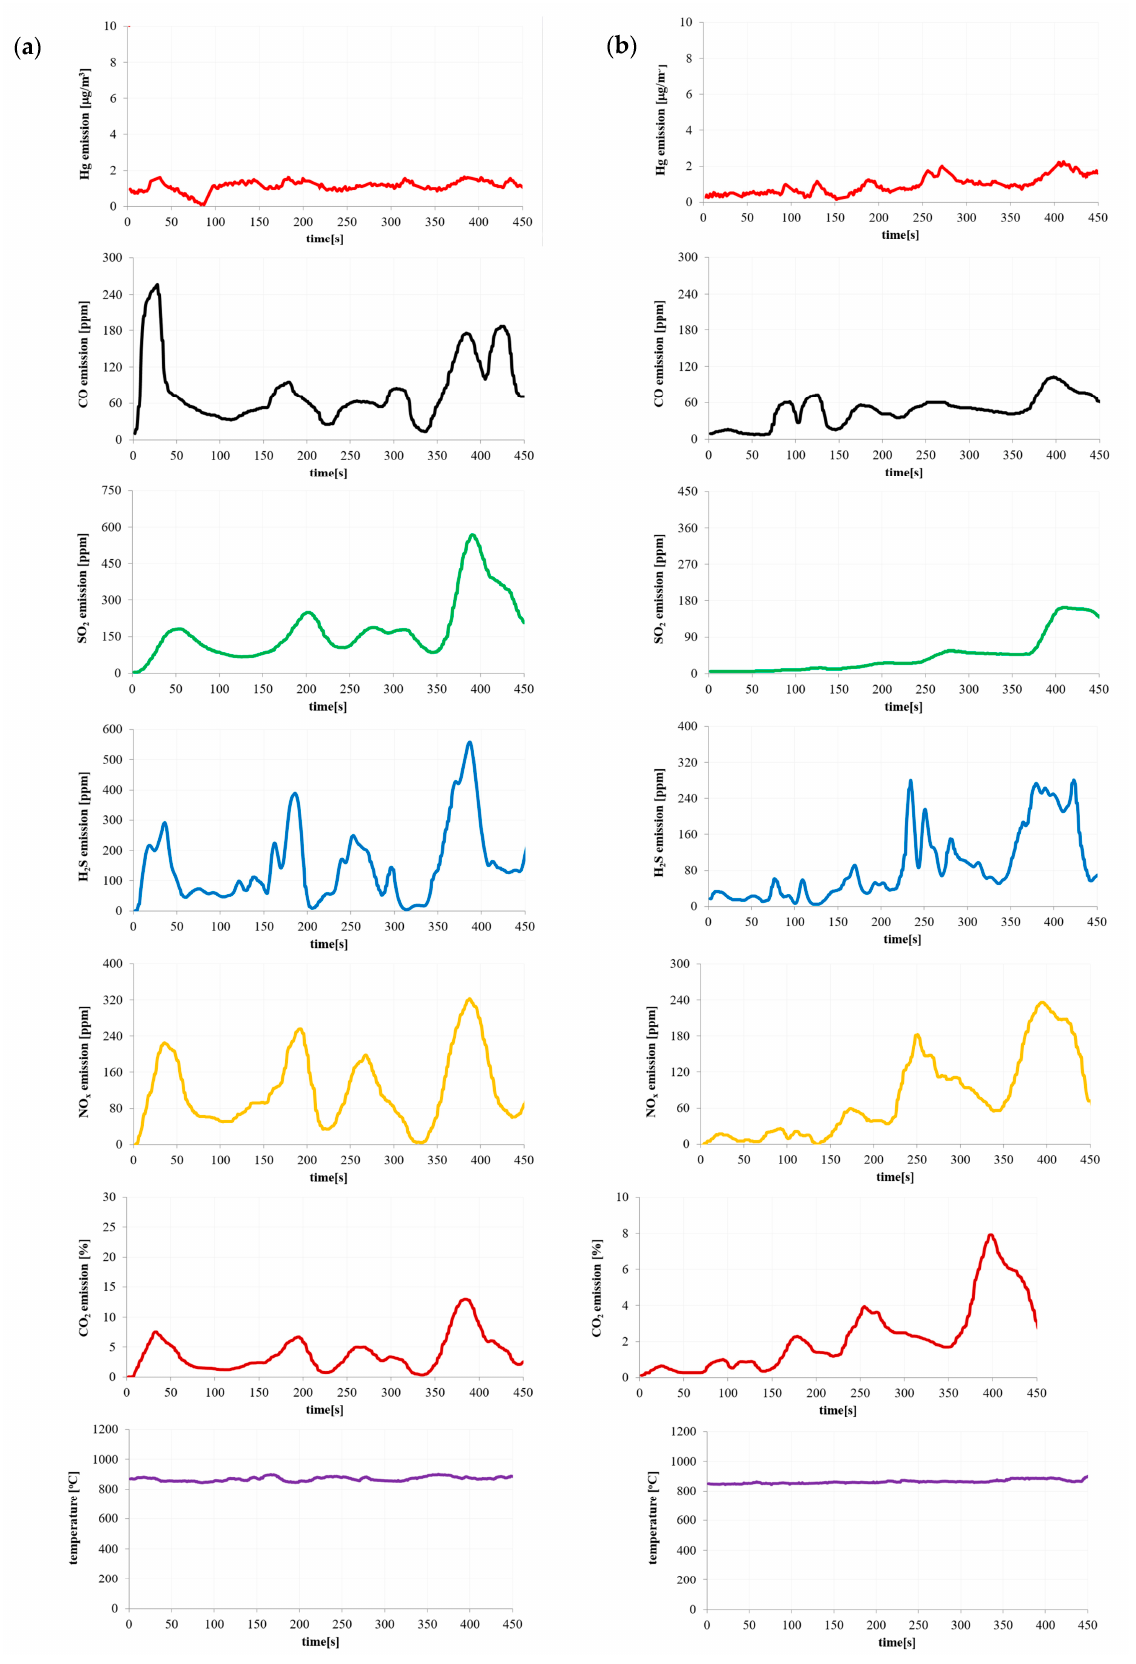
Figure 5. Emission of pollutants during ( a ) hard coal (90%) + polymer waste (10%) and ( b ) coal sludge (90%) + polymer waste (10%) combustion.